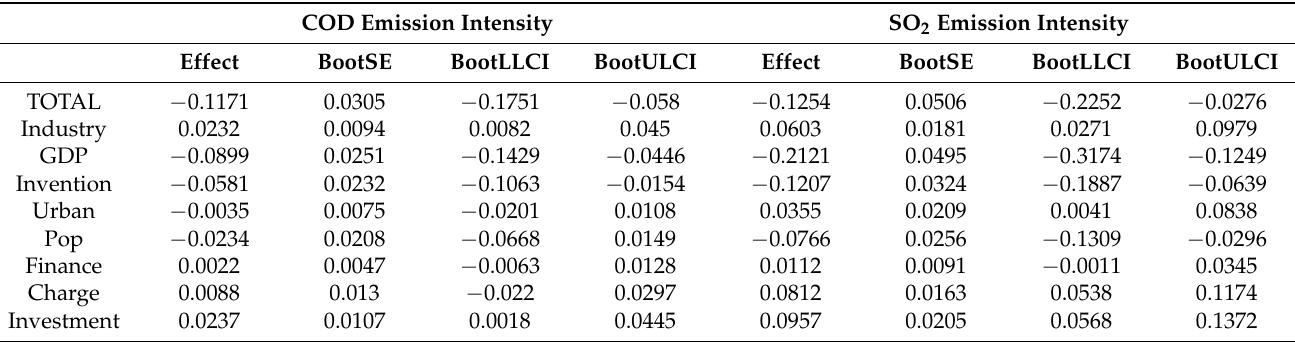
Table 7. The mediating effect of Eco-province policy.